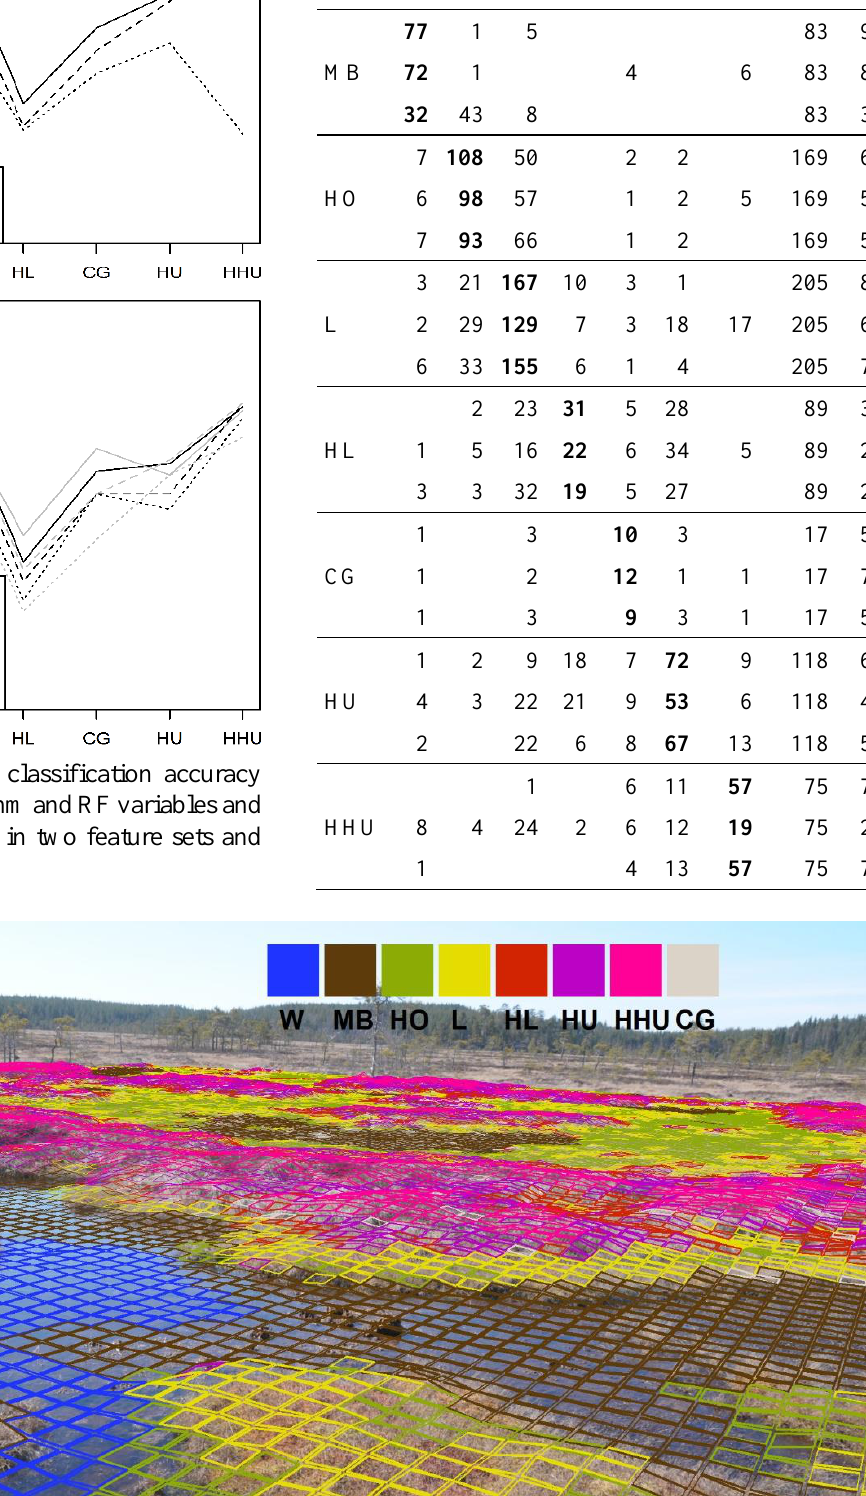
Figure 16. Visualisation of the resulting LDA-classified raster map with 20 × 20-cm cells. The location is shown in Figure